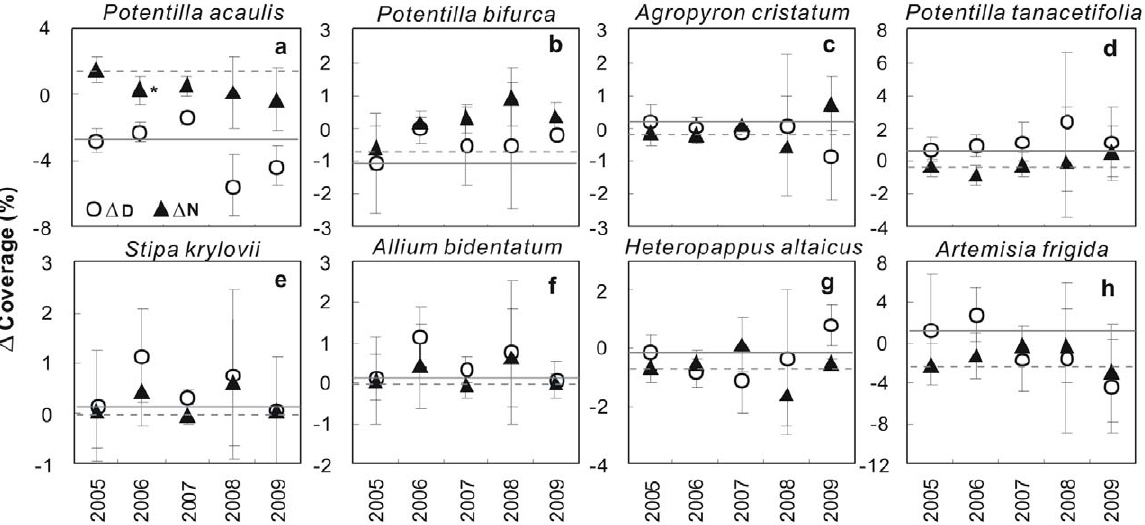
Figure 4. Coverage response of individual species to day (D) and night (N) warming from both pre-treatment (2005) and post- treatment (2006–2009). Pre-treatment (2005) values of day- and night-warming effects are indicated by horizontal gray solid and dashed lines, respectively. Means 6 SE are shown. *, P , 0.05. The y-axis is in different scales among the 8 species.